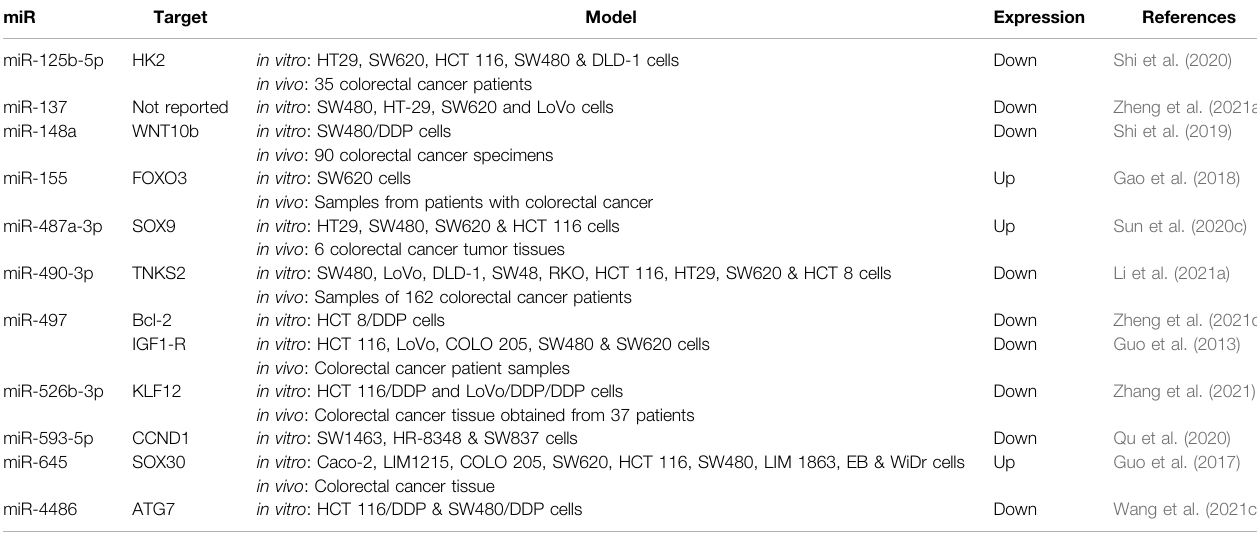
TABLE 5 | MicroRNAs involved in DDP-chemoresistance of colorectal cancer.